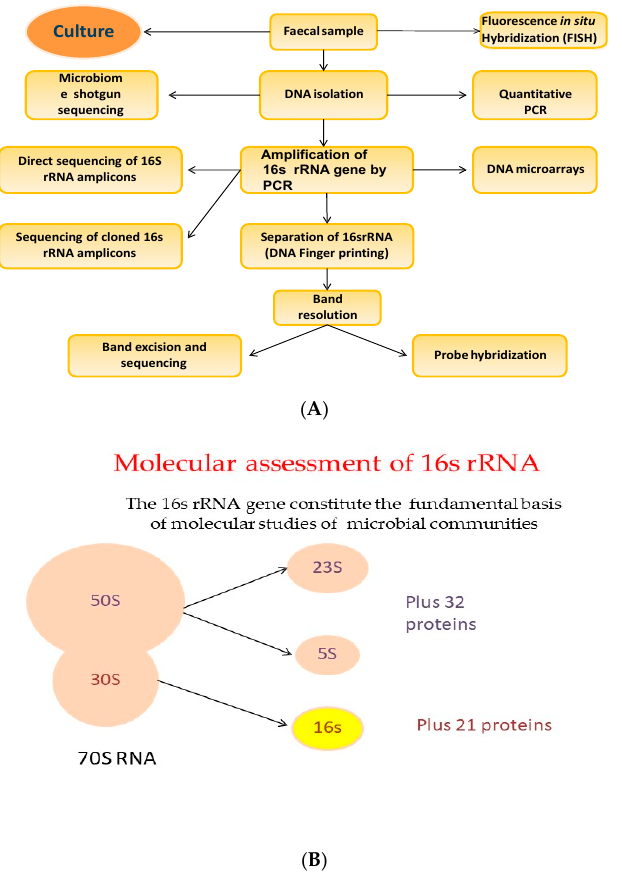
Figure 3. ( A ) Overview of techniques to characterize the gut microbiota. ( B ) The 16 s rRNA gene constitutes the fundamental basis of the molecular studies of microbial communities.